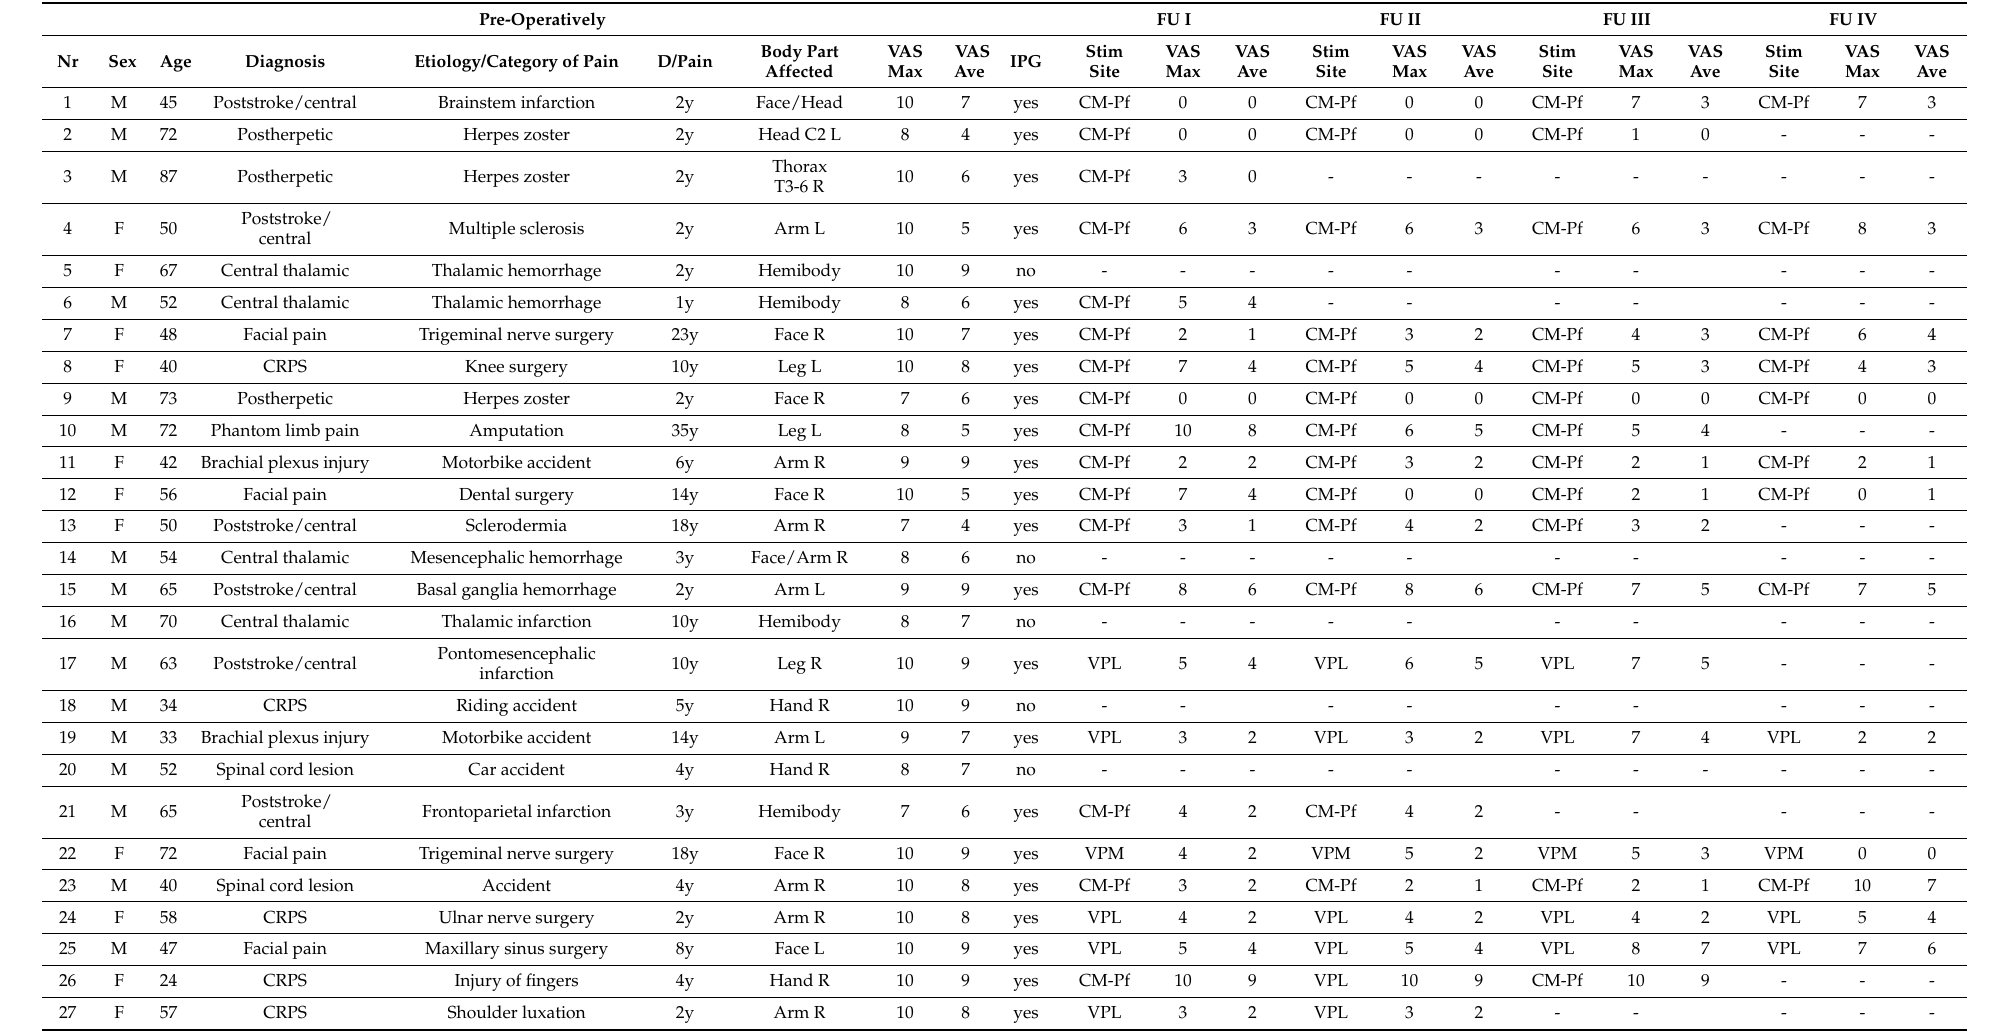
Table 1. Demographic, clinical and follow-up data of 40 patients with various neuropathic pain